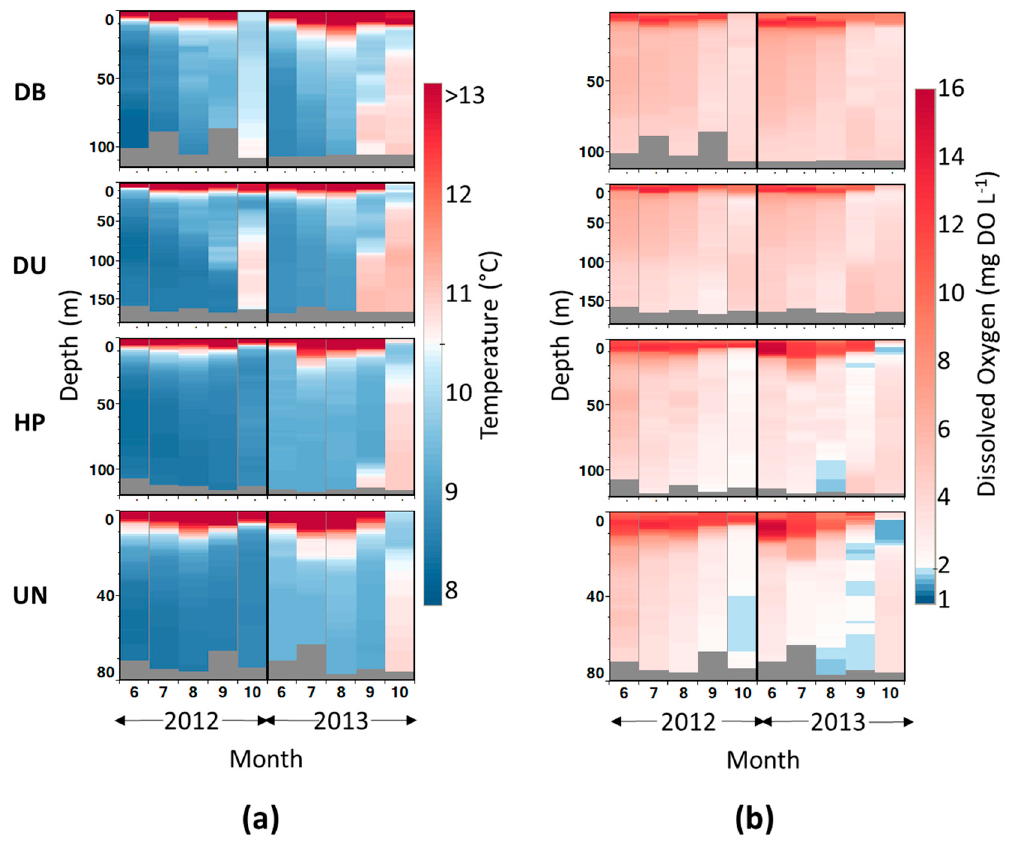
Figure 2. Seasonal profiles of ( a ) temperature ( ◦ C) and ( b ) dissolved oxygen concentrations (mg L − 1 ) at Dabob (DB), Duckabush (DU), Hoodsport (HP), and Union (UN). Red indicates higher temperatures and dissolved oxygen concentrations, while blue indicates lower temperatures and dissolved oxygen concentrations ≤ 2.0 mg L − 1 .